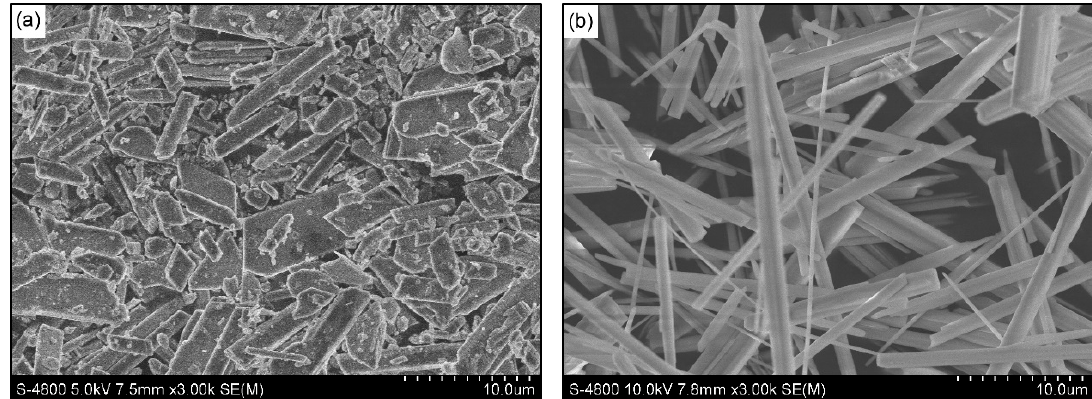
Figure 3. Scanning electron microscopy (SEM) micrographs of ( a ) Dihydrate (DH) precursor and ( b ) the synthesized powder.